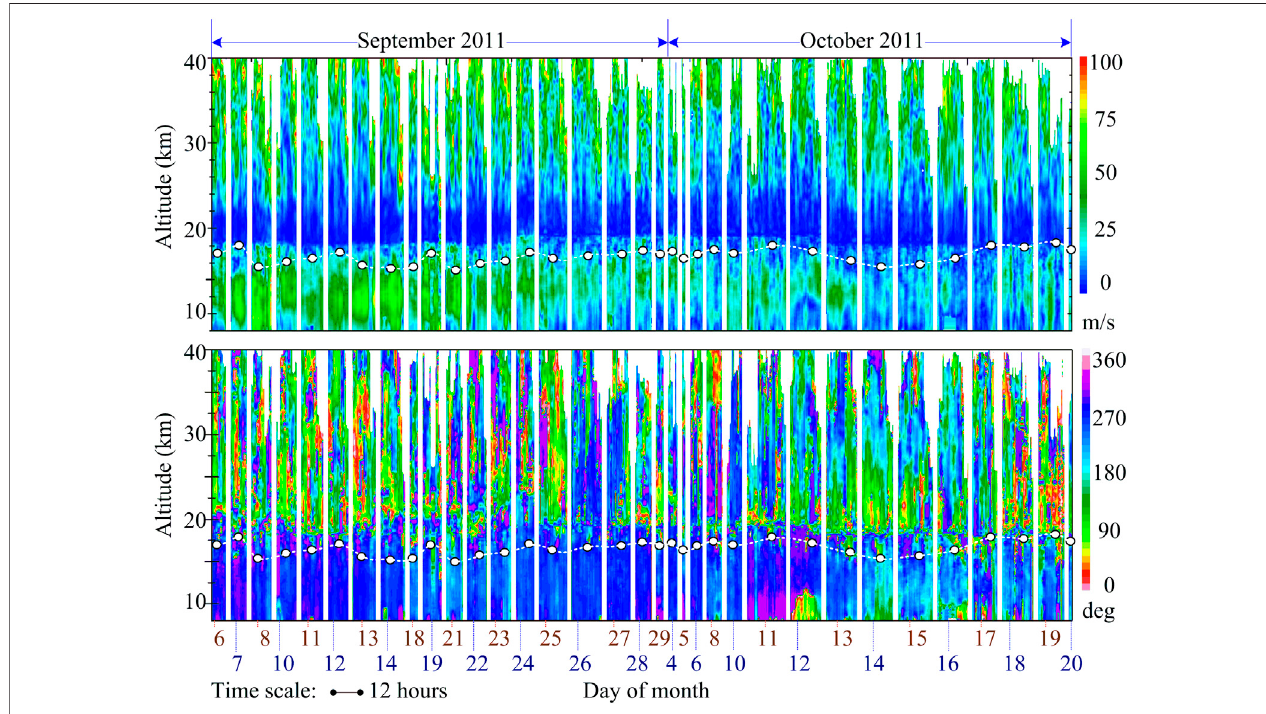
FIGURE 1 | Time – altitude plot of semi-continuous observation of mid-altitude wind fi eld from University of Science and Technology of China (USTC) Rayleigh Doppler wind lidar (DWL).